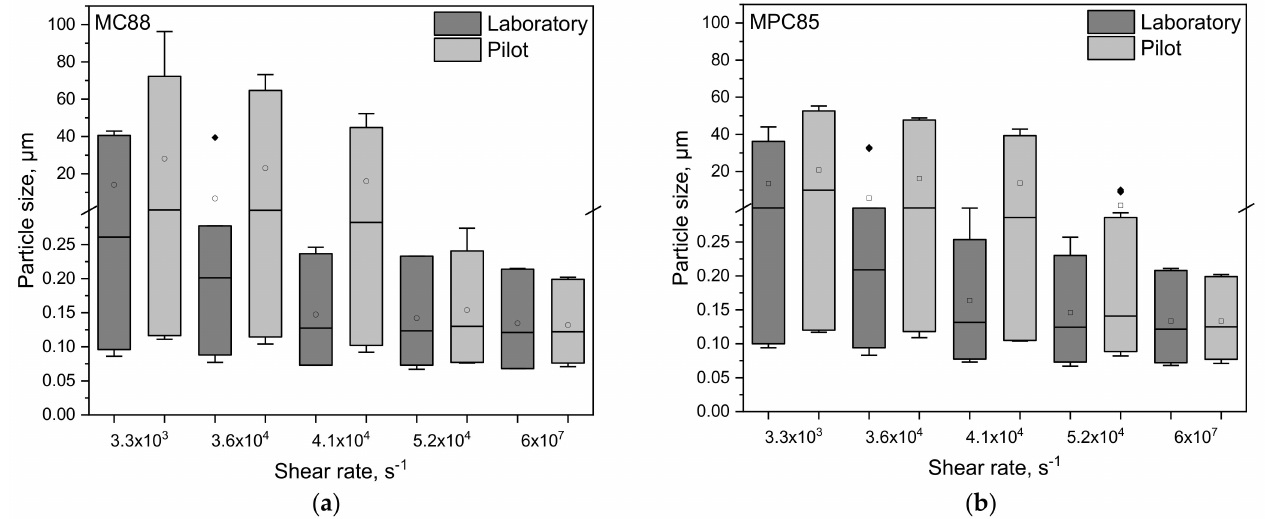
Figure 7. d 10,3 , d 50,3 , and d 90,3 values observed in laboratory (dark grey) and pilot scale (light gray) presented as boxplots of skim milk enriched with MC88 ( a ) and MPC85 ( b ). The low and high quartiles, the median, and the mean ( (cid:3) ) are plotted. ( (cid:7) ) represents outliers.